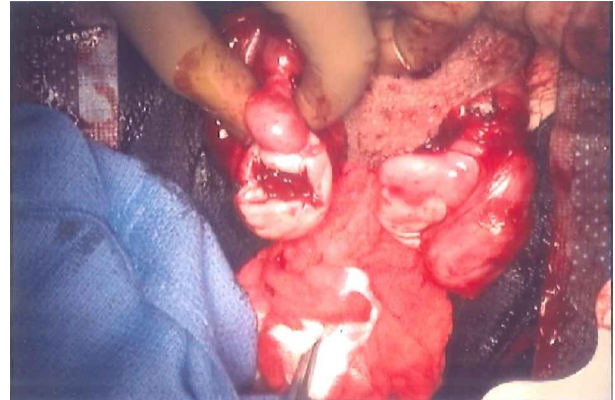
Figure 1. An almost completely hemispheric, circumferential testic- ular rupture is visualized at the mid-pole right testicle on intraoper- ative inspection. Note that the left testicular injury has already been repaired.